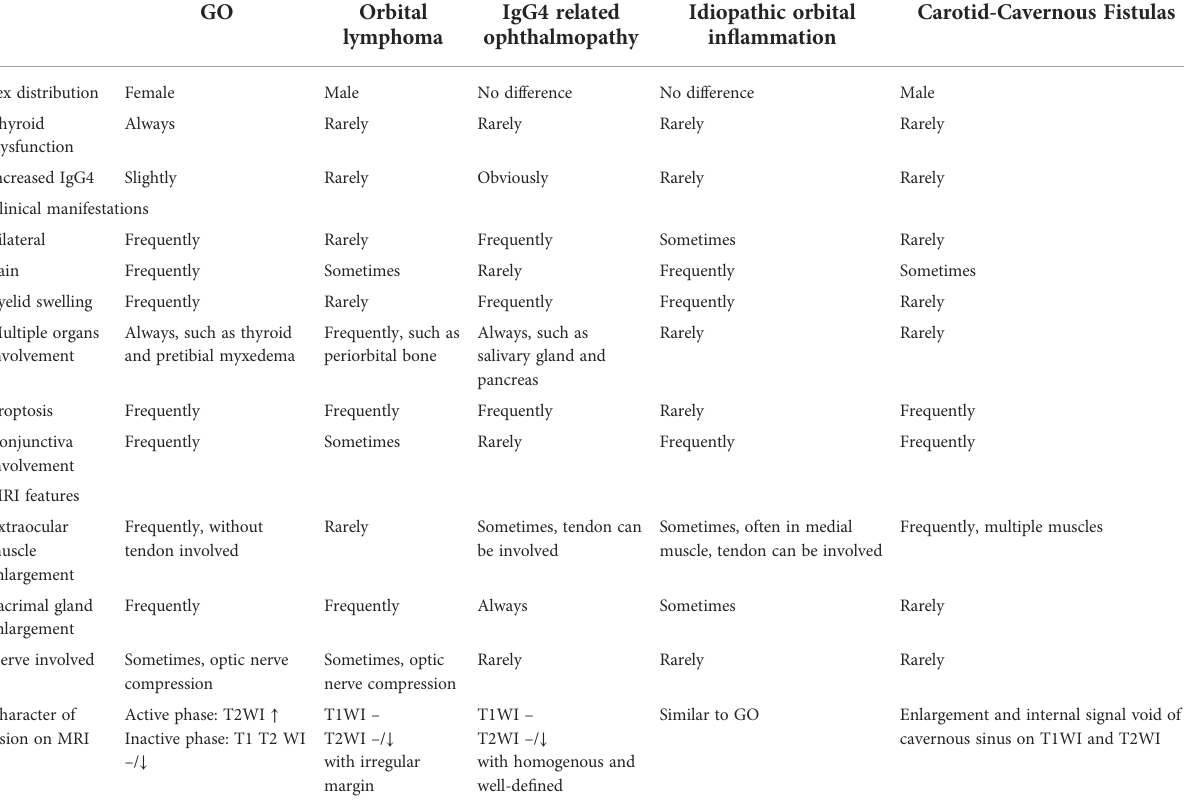
TABLE 2 Differential diagnosis of